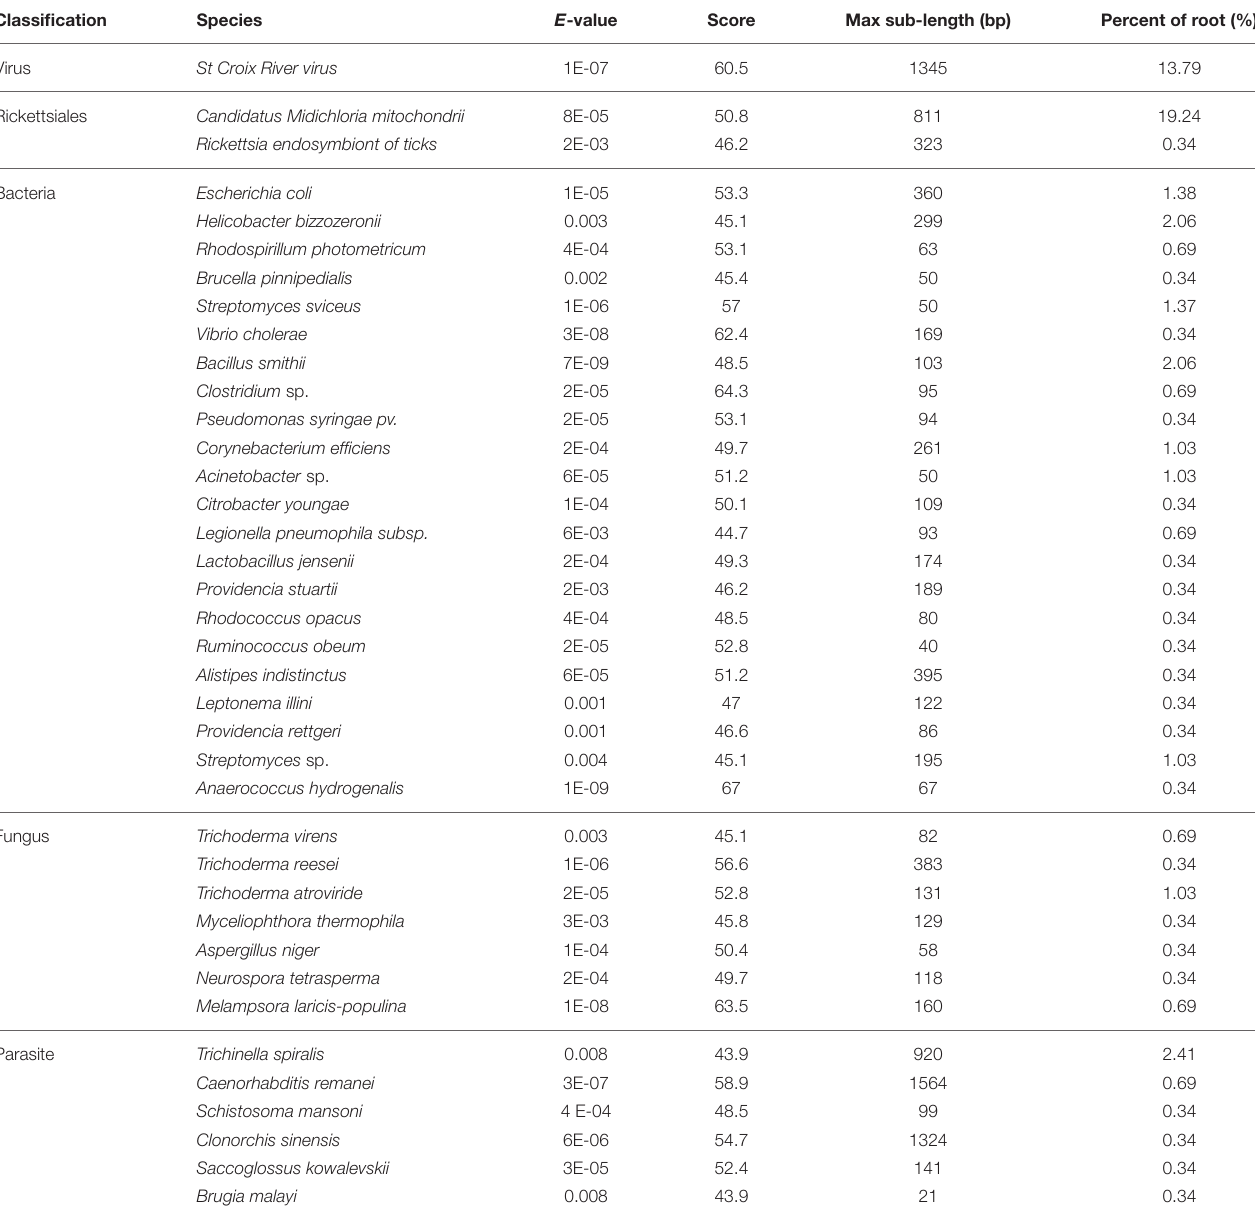
TABLE 3 | Summary of the bioinformatics data assembly and micropathogen diversity analysis.